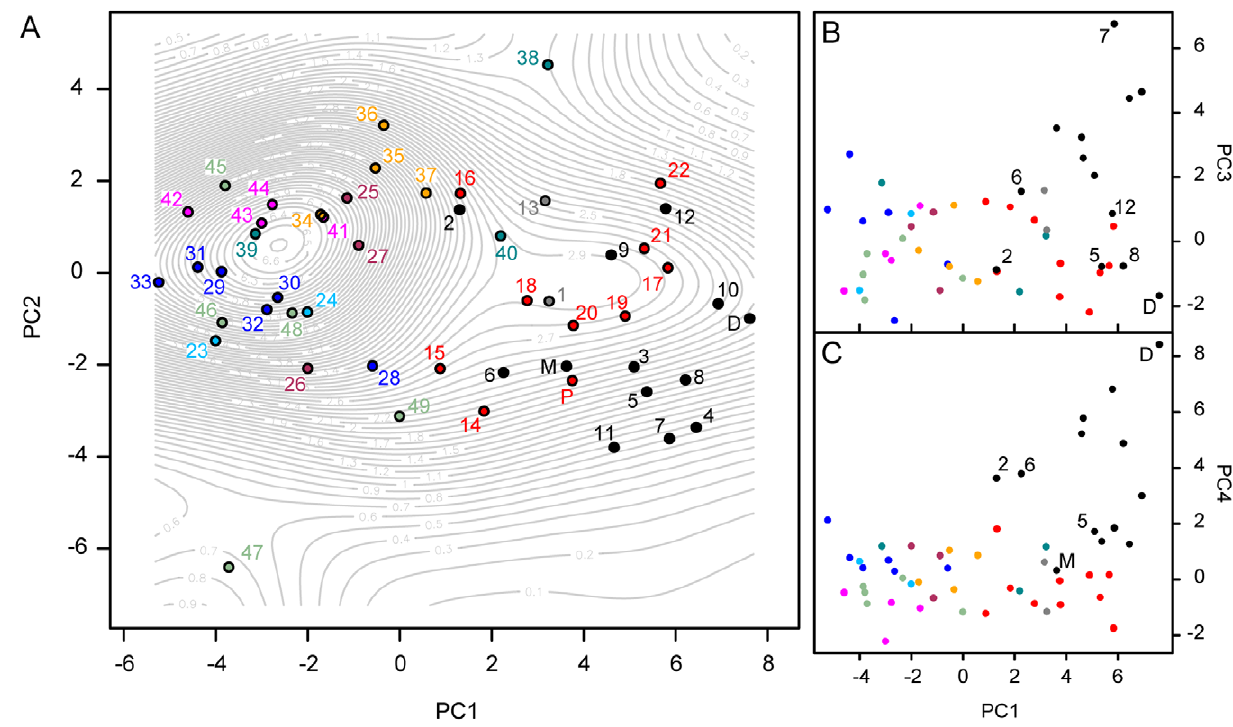
Figure 4. Two-dimensional morphospace plots of species centroids (color-coded spheres) based upon PCA of 29 size-adjusted cranial linear variables in 332 specimens of extant and fossil felids. (A) Two-dimensional morphospace plot delimited by PC1 and PC2, with contour lines showing the spatial density of the specimen-level distribution. (B) Two-dimensional morphospace plot delimited by PC1 and PC3. (C) Two-dimensional morphospace plot delimited by PC1 and PC4. Taxa labels are the same as in Fig. 2, except as follows: D, Dinobastis serus ; M, Metailurus IVPP-5679; P, Panthera paleosinensis ; these three taxa were not included in the phylogeny. Color codings are as in Fig. 2.